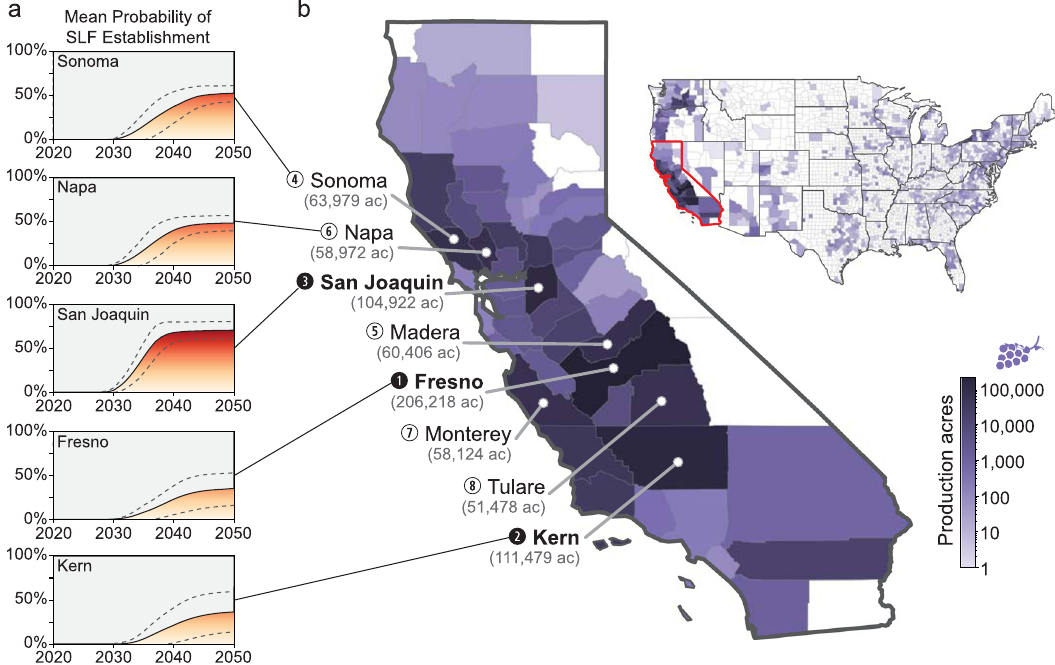
Fig. 4 Probability of SLF establishment in grape-growing counties. a Mean probability of SLF establishment over time (average of all pixel probabilities in the county), based on PoPS output, in the three grape-producing California counties with production >100,000 acres, plus Sonoma and Napa Counties, which produce high-value wine grapes. Asymptotes do not reach 100% probability, because some pixels in each county are unsuitable for SLF and have a 0% probability of establishment; asymptotes are reached when all suitable pixels in a county are predicted to be infested by SLF. Dotted lines represent standard deviation across runs. b Grape acreage under production based on the USDA National Agricultural Statistics Service 2017 census 10 , highlighting the eight counties with the most grape production.